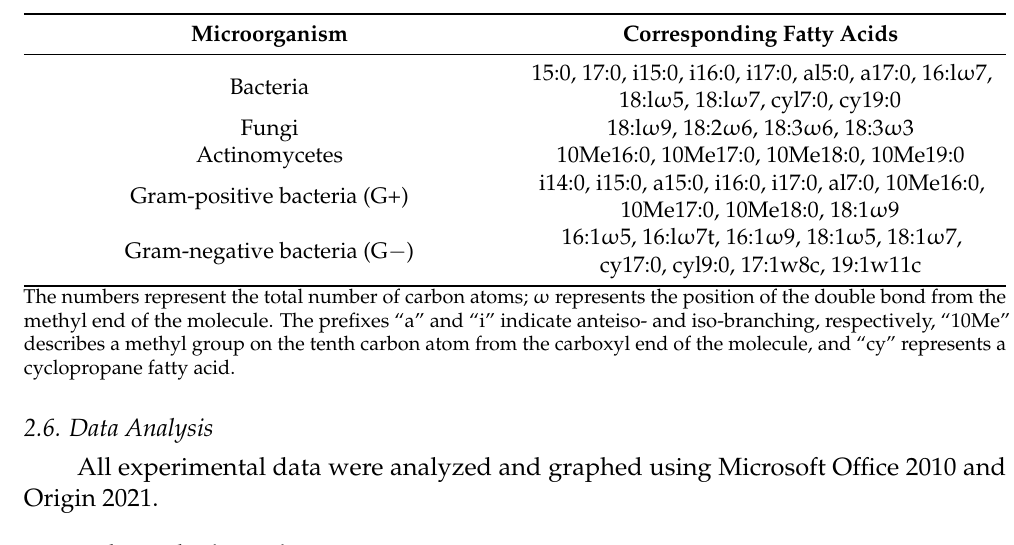
Table 2. Indicative fatty acids for soil microbial biomass